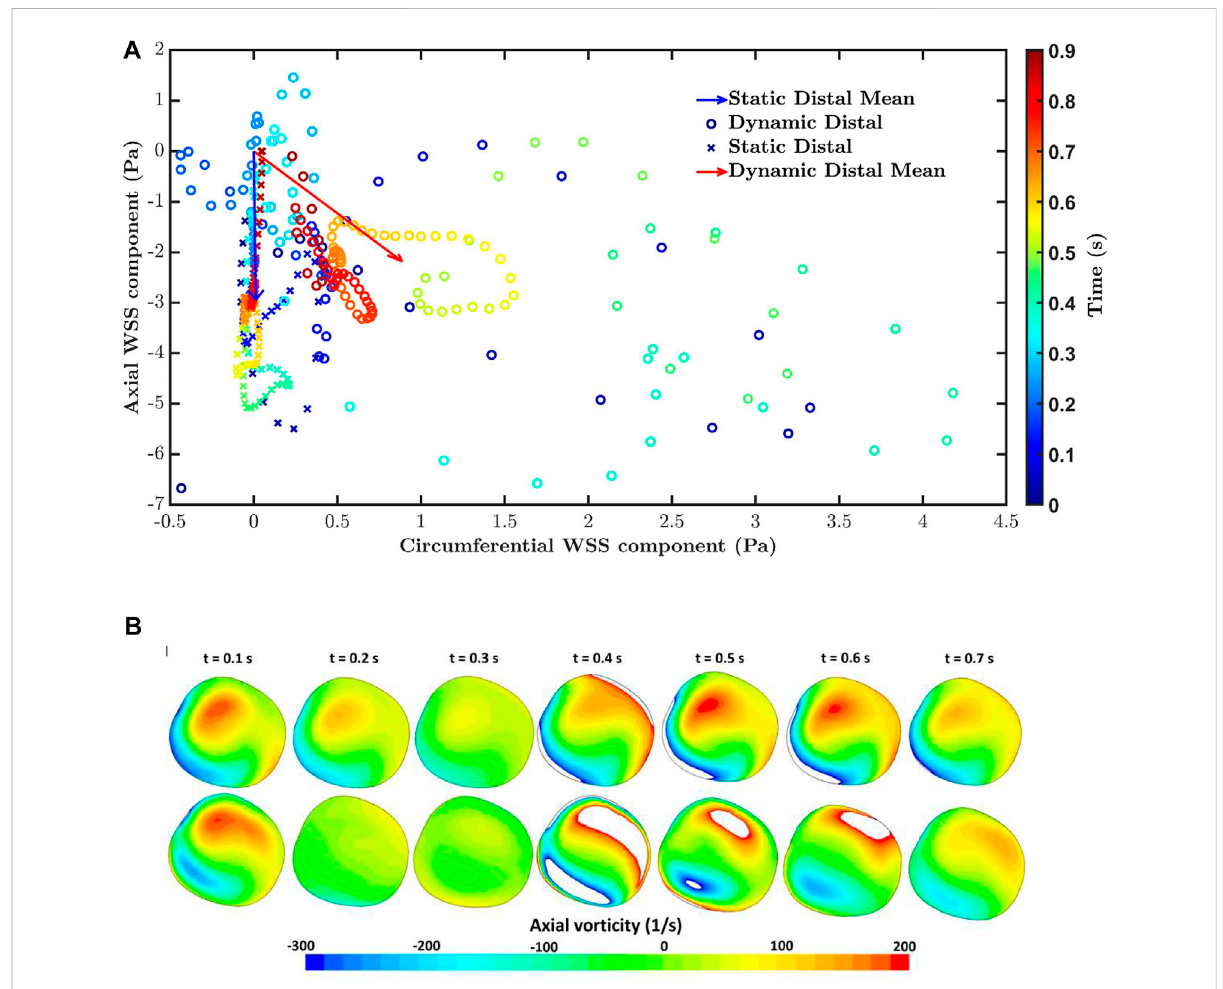
FIGURE 6 (A) The polar plot and mean vector for static pulsatile and dynamic pulsatile cases for a distal location in the RCA (Region 1 in Figure 4), where transWSS differedsubstantially betweenthetwocases.Negative valuesofaxialWSSindicate fl owtravellingdownthevessel. (B)